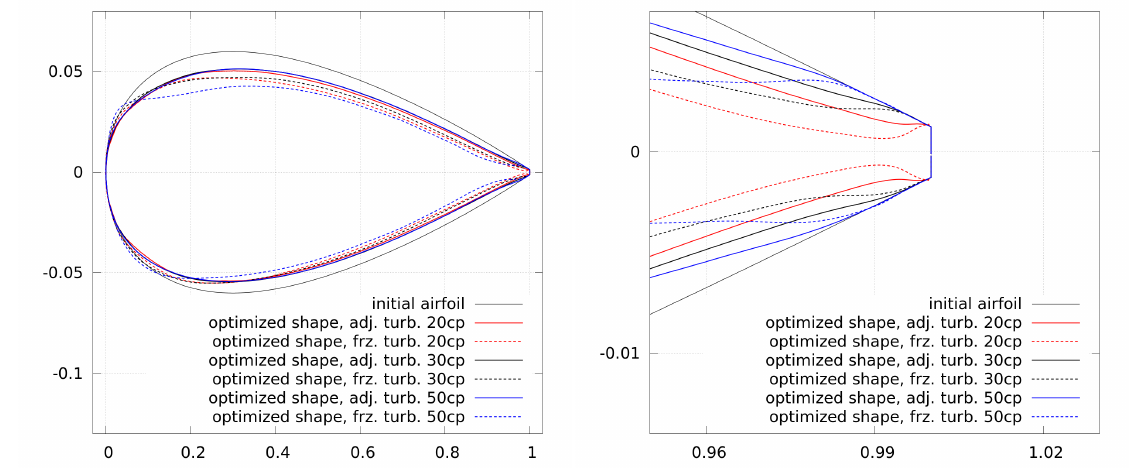
Figure 9. Airfoil shapes using adjoint and frozen turbulence for the NACA 0012 at AoA = 2 ◦ . The objective is a decrease in drag by 3%. Frozen as well as adjoint turbulence are used. The number of control points is labeled as